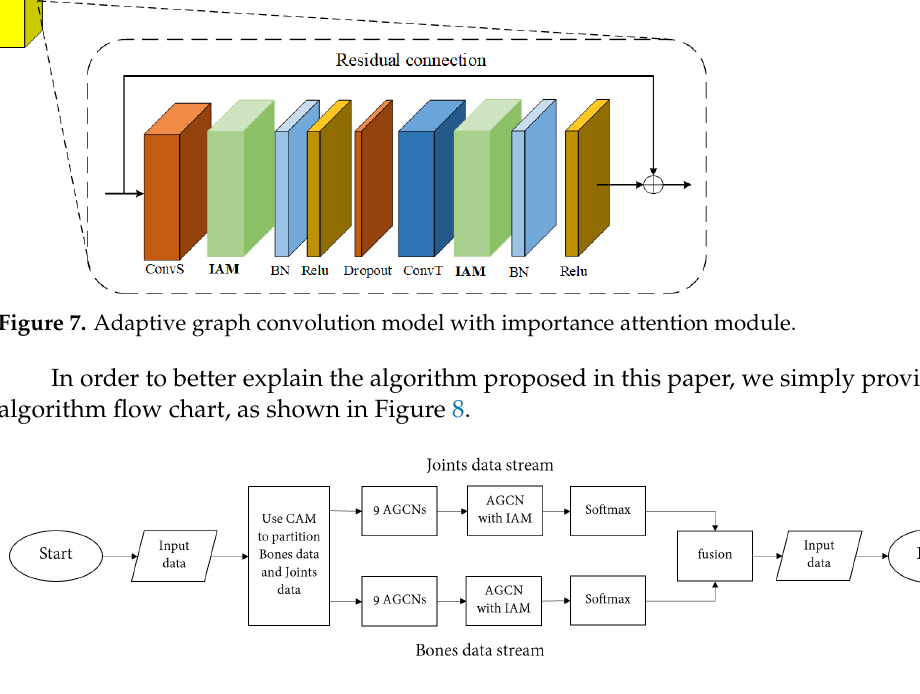
Figure 8. Flowchart of the